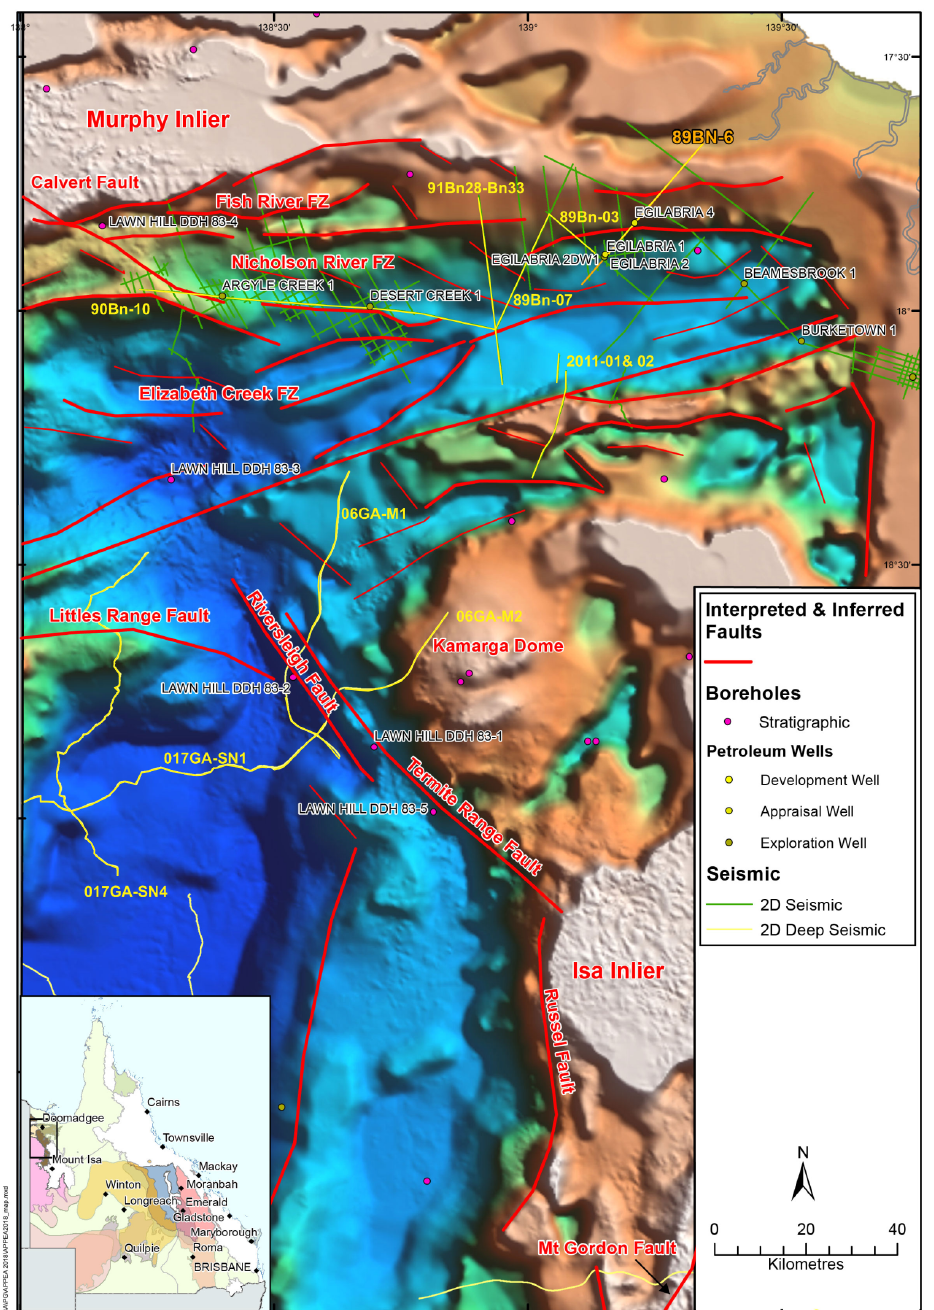
Figure 5. Basin and basement architecture for northern Lawn Hill Platform showing the main depocentres, fault trends, and depth to magnetic basement for the Isa Superbasin (after Gorton and Troup, 2018, from image created by Frogtech Geoscience, 2018). Seismic lines are shown in various colours and include the 1994 (Comalco) and 2011 (Teck Resources) industry surveys across the Isa Superbasin and adjacent Punjaub Structure (P). Yellow lines are for composite image presented in Figs. 6–7. Note the compartmentalization of depocentres brought about by interference between the ENE- and NW-trending faults; the latter are of Calvert age and include older normal faults (e.g. Riversleigh Fault) reactivated as strike-slip structures during crustal extension accompanying formation of the Isa Superbasin. The figure is reproduced with permission under the Creative Commons Attribution 4.0 International Licence: